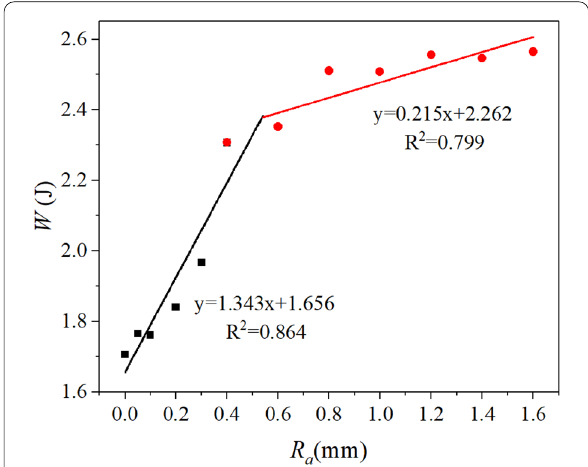
Fig. 18 Variation of dissipated fracture energy with aggregate surface